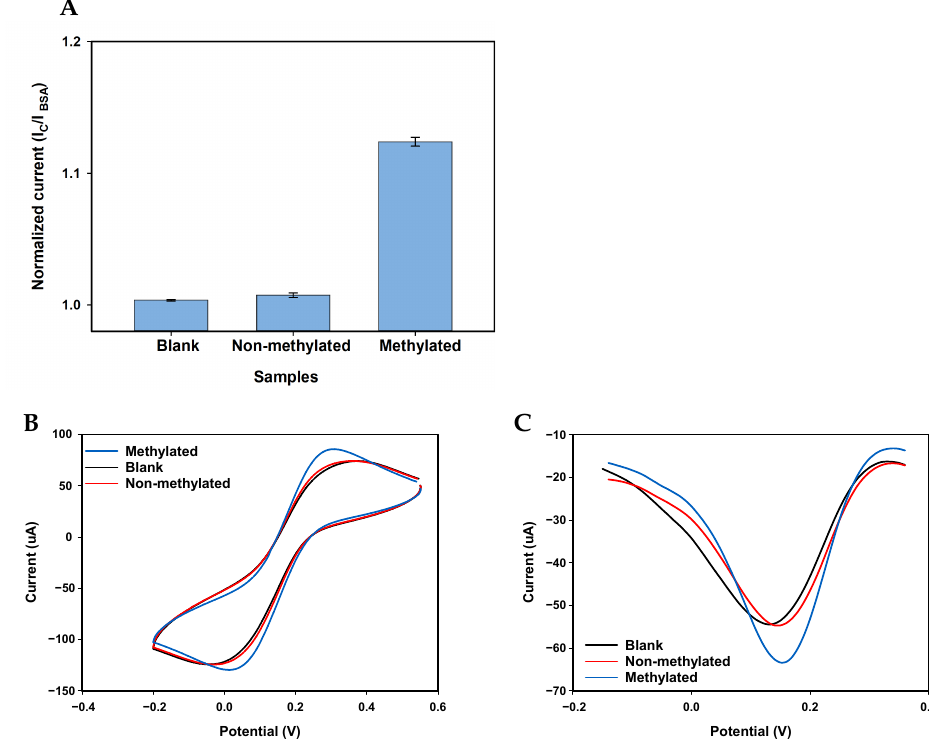
Figure A6. Comparison of the responses obtained from various targets (methylated, non-methylated and blank) using the proposed biosensor. Normalized CV peak current for different samples measured on three different replicas ( A ). CV ( B ) and DPV ( C ) voltammograms of one replica for each